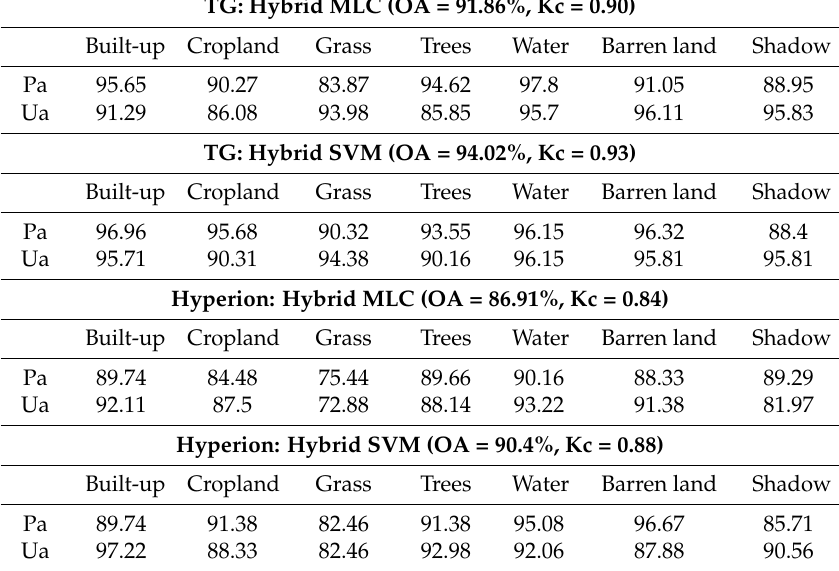
Table 5. Confusion matrices and associated hybrid classifier accuracy with the best OA in regard to sensors of TG-1 and Hyperion